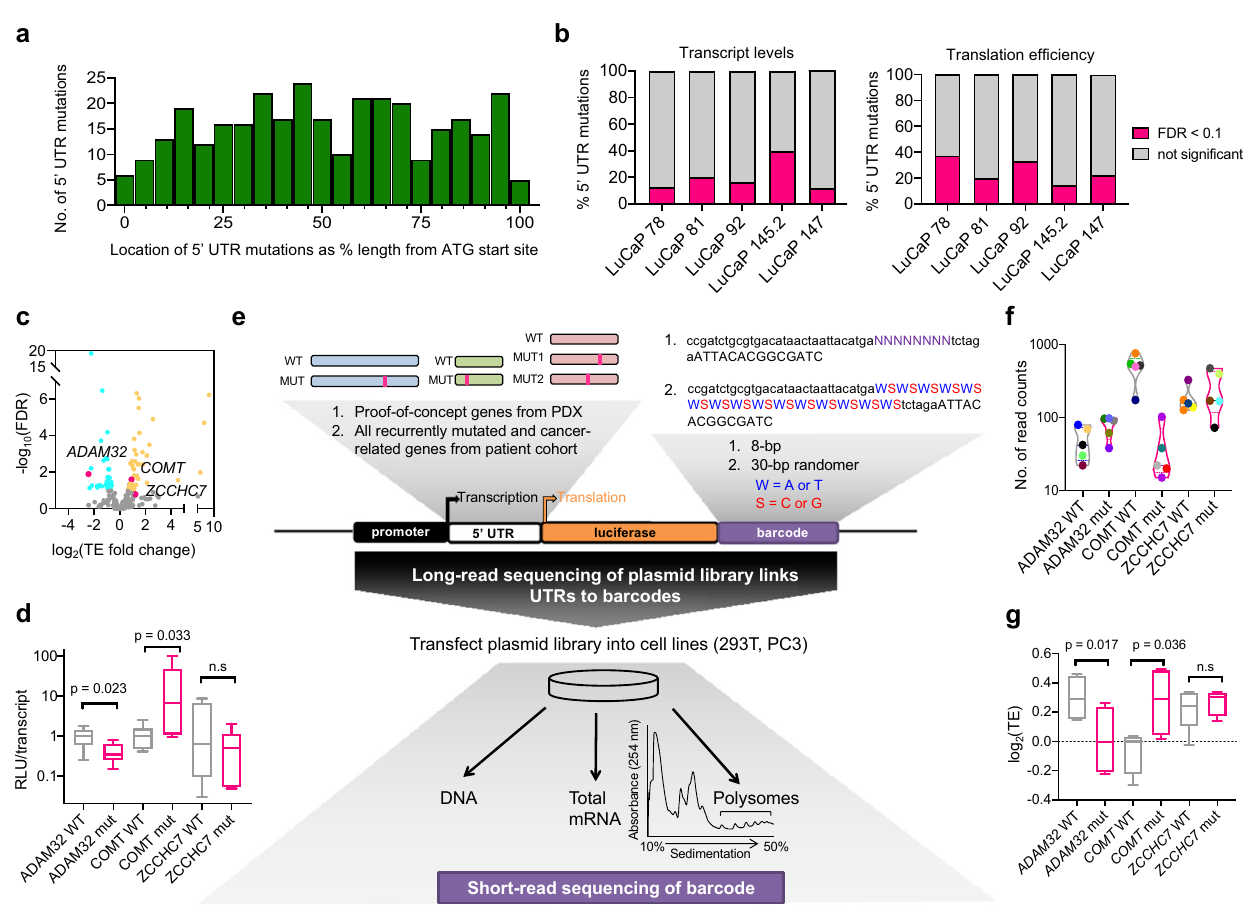
Fig. 1 Development of a massively parallel reporter assay to quantify the impact of 5 ′ -UTR mutations on transcript levels and mRNA translation. a Histogram of the genomic distribution of all somatic single-nucleotide 5 ′ -UTR mutations in fi ve prostate cancer patient-derived xenografts (PDX) from the LuCaP series. b Percentage of 5 ′ -UTR mutations in each LuCaP PDX that signi fi cantly alter transcript or mRNA translation ef fi ciency (TE) levels (FDR < 0.1, represented in pink). Across fi ve xenografts representing a spectrum of advanced human prostate cancer (adenocarcinoma, neuroendocrine prostate cancer, hypermutated prostate cancer), 13 mutations exhibited a decrease in transcript levels, while 35 mutations exhibited an increase. At the level of translation, 31 5 ′ -UTR mutations decreased ribosome occupancy (decreased translation ef fi ciency [TE]), while 42 had the opposite effect, independent of changes at the mRNA level. c Volcano plot showing TE fold changes of all 5 ′ -UTR mutations in these LuCaP PDXs. Each dot represents TE fold change of a 5 ′ -UTR mutation; turquoise dots are 5 ′ -UTR mutations that signi fi cantly downregulate TE of its speci fi c mRNA (FDR < 0.1), yellow dots are 5 ′